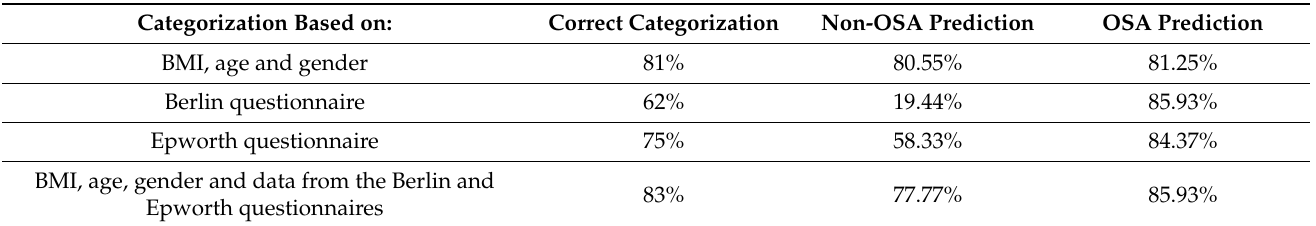
Table 14. Accuracy of categorisation tests based on different information sets. OSA: obstructive sleep apnoea; BMI: body mass index.